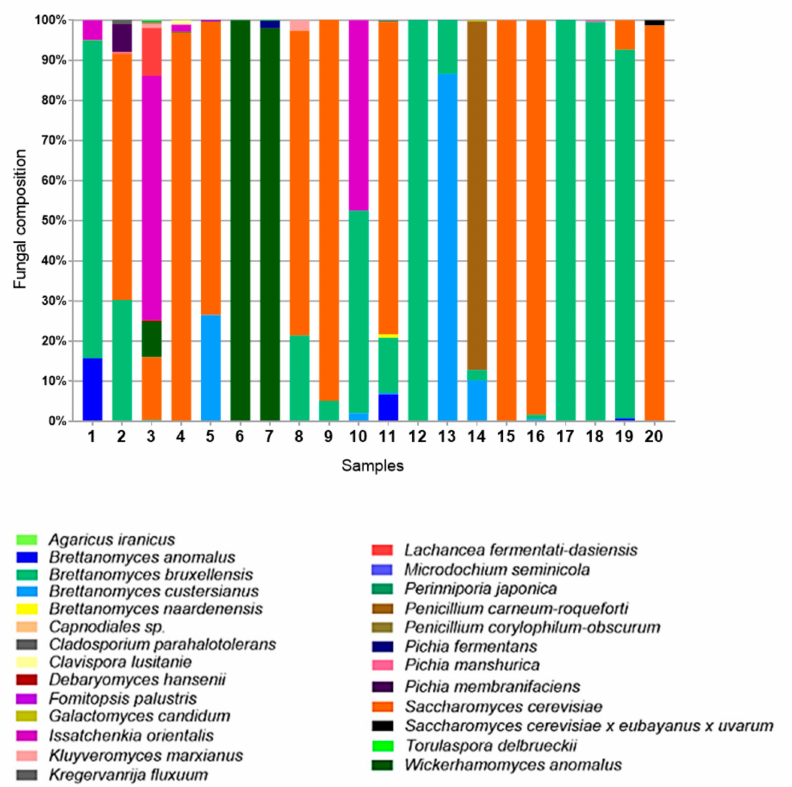
Figure 5. Fungal composition of the 20 samples analyzed. Fungal identification was performed from ASVs originating from NGS of the ITS2 region, amplifying the entire ITS region. Colors for identification were designed according to the fungal species as shown below the